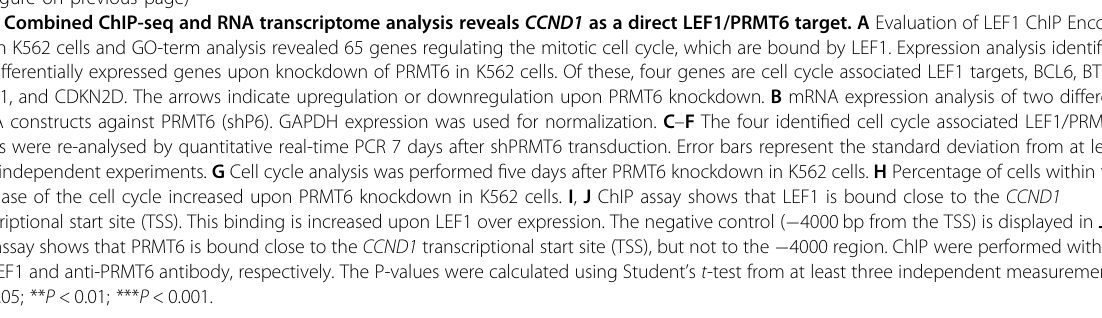
on the CCND1 promoter (Fig. 6E). This supports the